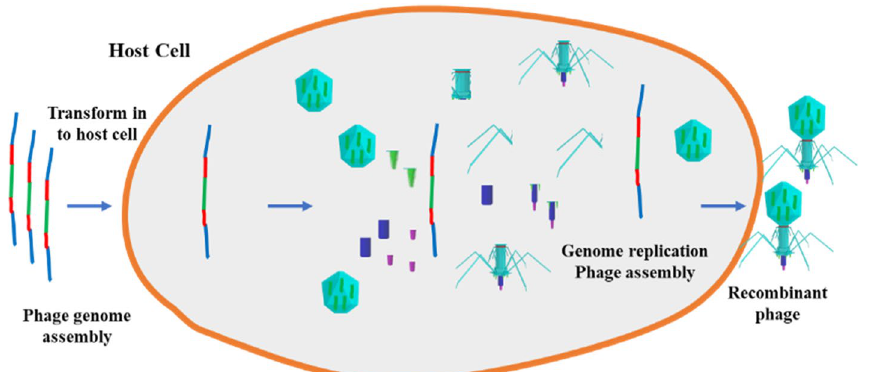
Fig. 5 Phage rebooting and assembly by genomic DNA. Host-cell machinery DNA of phage is incorporated in to the newly produced recombinant infectious